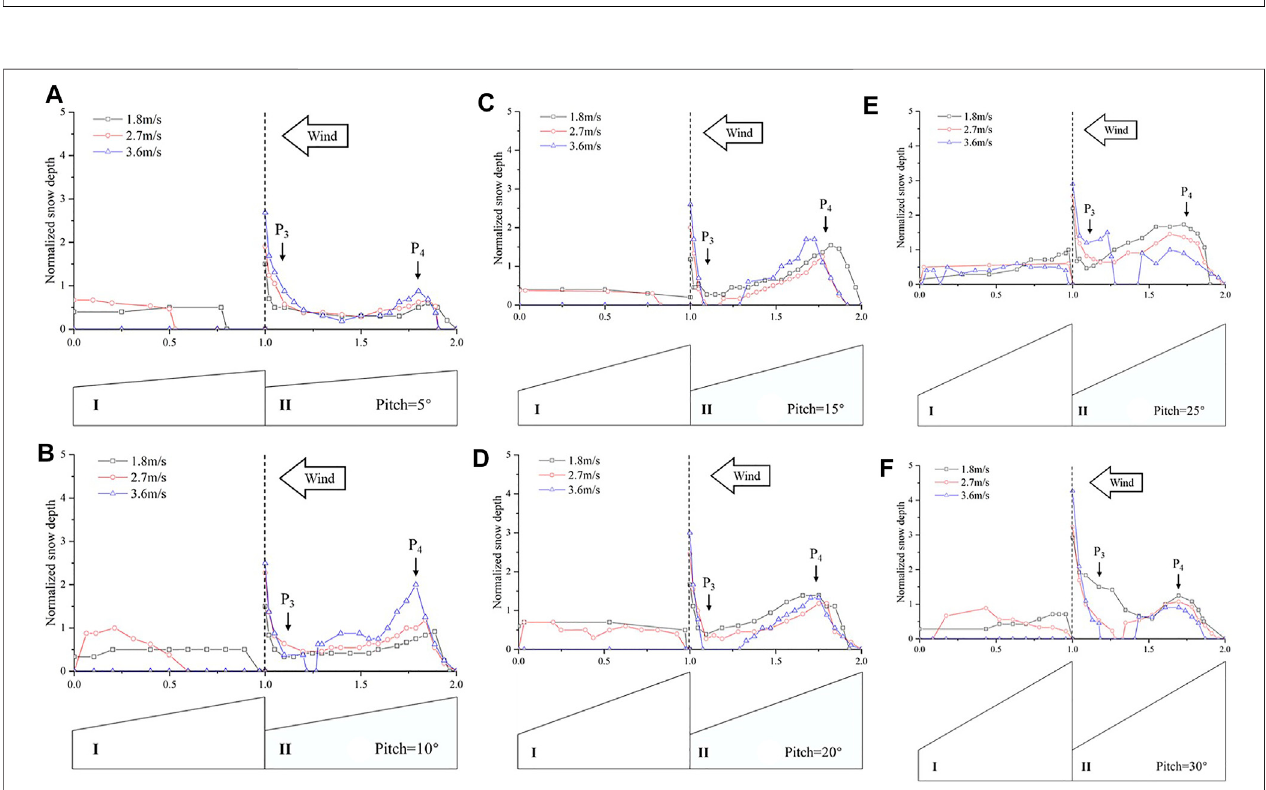
FIGURE 9 | Normalized snow depth along the centerline of the roof for the positive wind direction. (A) pitch = 5 ° (B) pitch = 10 ° (C) pitch = 15 ° (D) pitch = 20 ° (E) pitch = 25 ° (F) pitch = 30 ° .